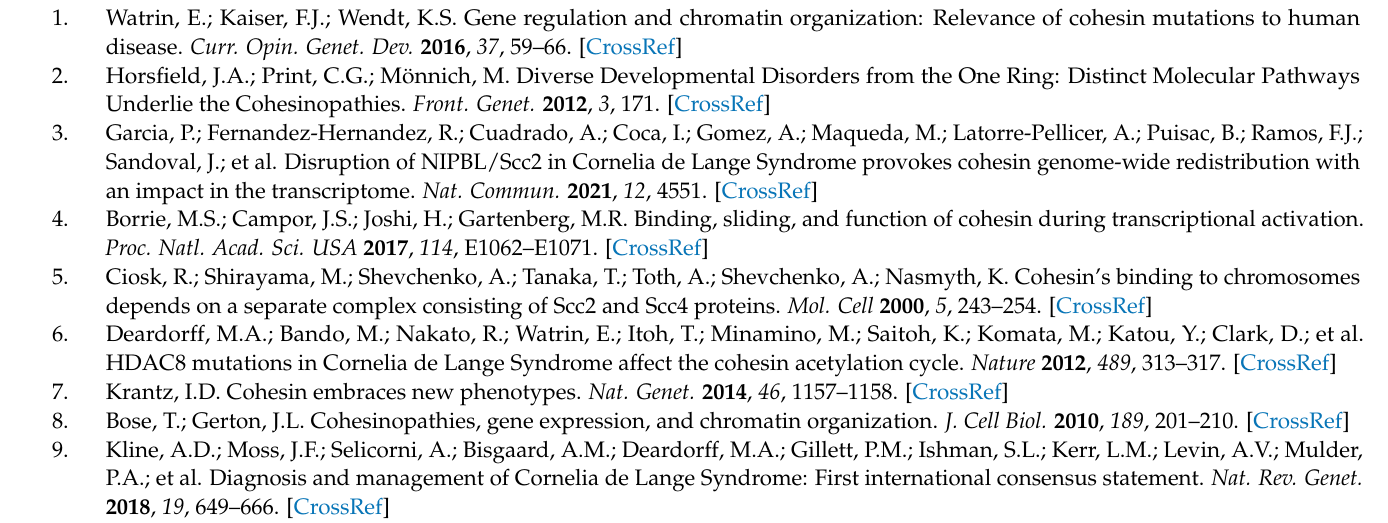
Nanostring approach. Table S3. Quantitative CpGs methylation results of IGF2/H19 (IC1), MEST, PEG10, GNAS and GNAS-AS1 DMRs in CTRL and CdLS cell